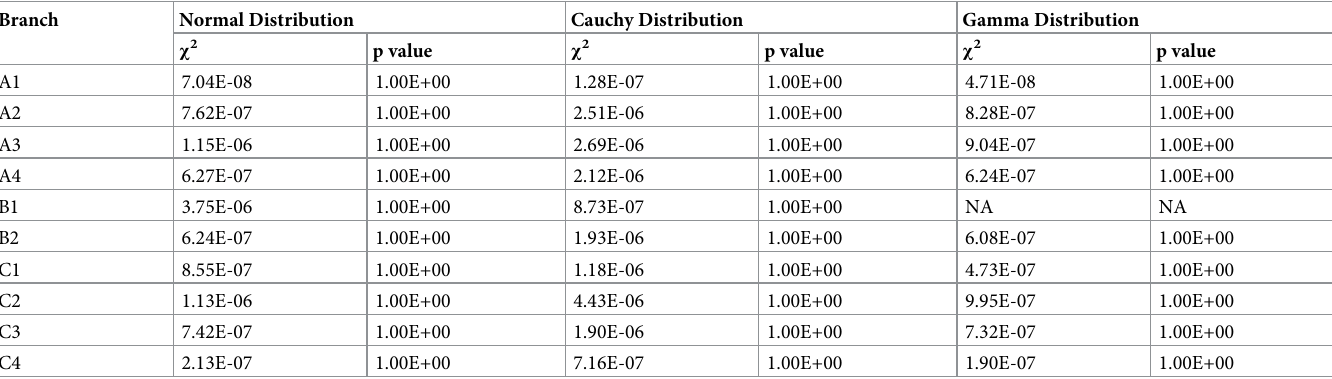
Table 10. Distribution fitting results of (COCI) prediction